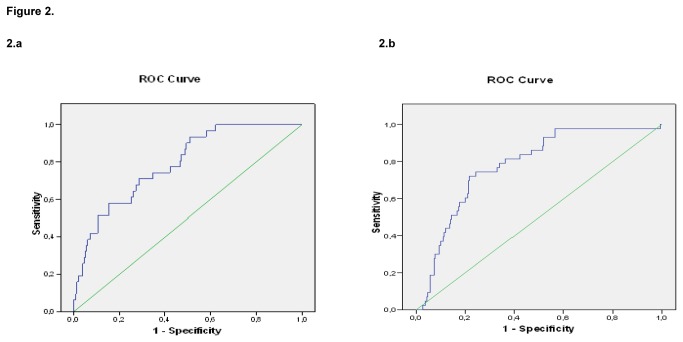
Area under the ROC curve for women (2.a) and men (2.b).The calculated cardiovascular risk correctly classified overall 78.9% (95%CI, 71.6-86.3) of the women and 78.0% (95%CI, 71.3-84.7) of the men (P<0.001 both).